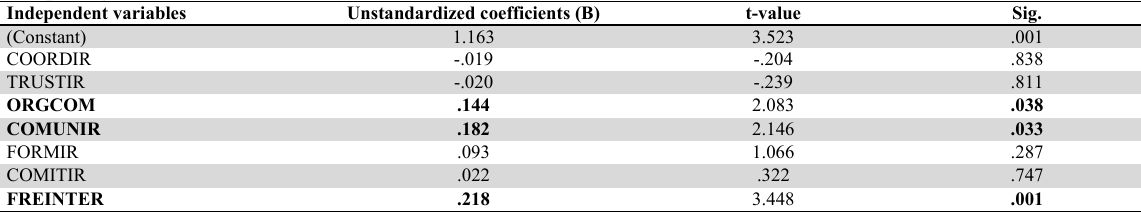
Multiple regression coefficients analysis for H1 Independent variables